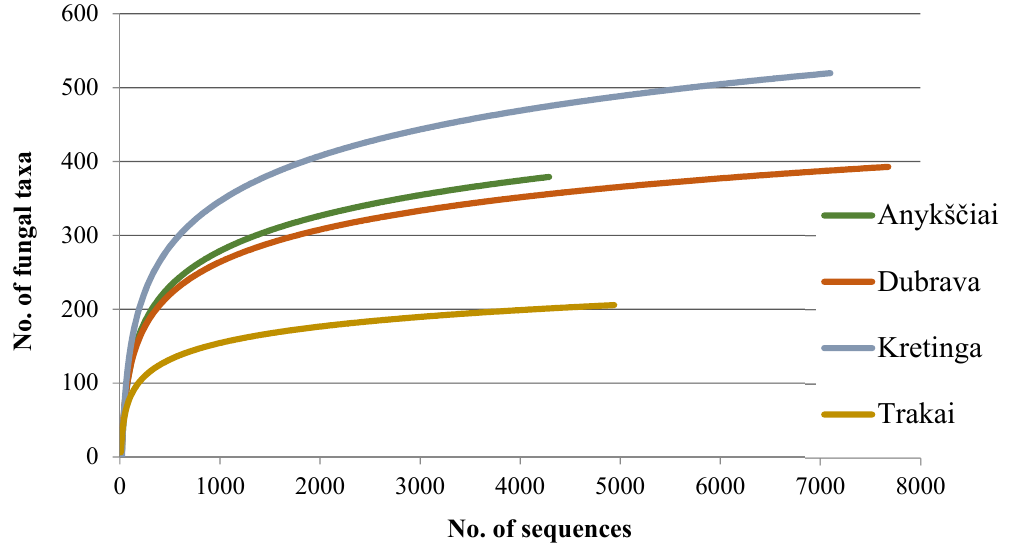
Figure 1. Species accumulation curves showing the relationship between the cumulative number of taxa and the number of ITS rDNA sequences from four water ponds used for seedling irrigation in forest nurseries.